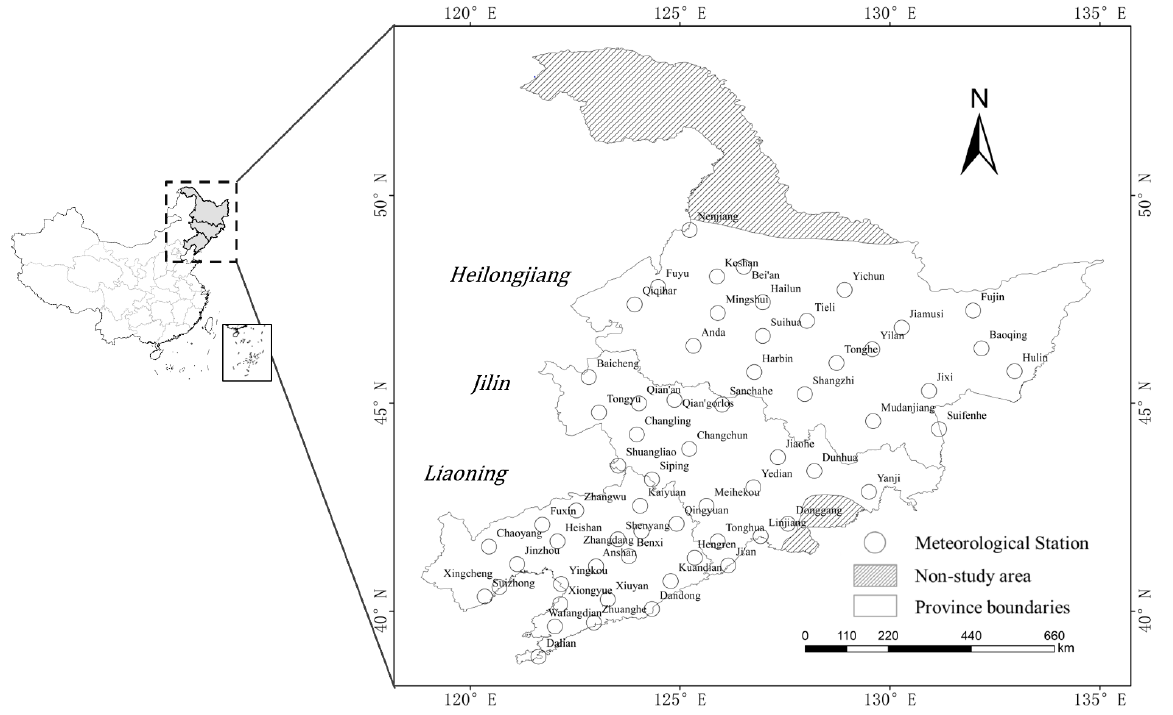
Figure 1. Study area and meteorological stations in Northeast China (the three provinces from north to south are Heilongjiang, Jilin, and Liaoning).